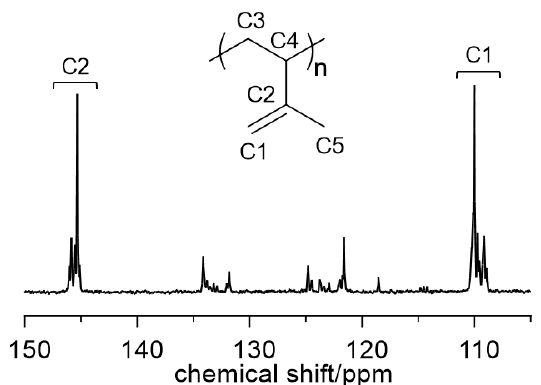
Figure 3. The 13 C NMR spectrum (olefinic region) of 3,4 syndiotactic poly(isoprene) obtained with CuCl 2 (bipy)/MAO (Table 1, entry